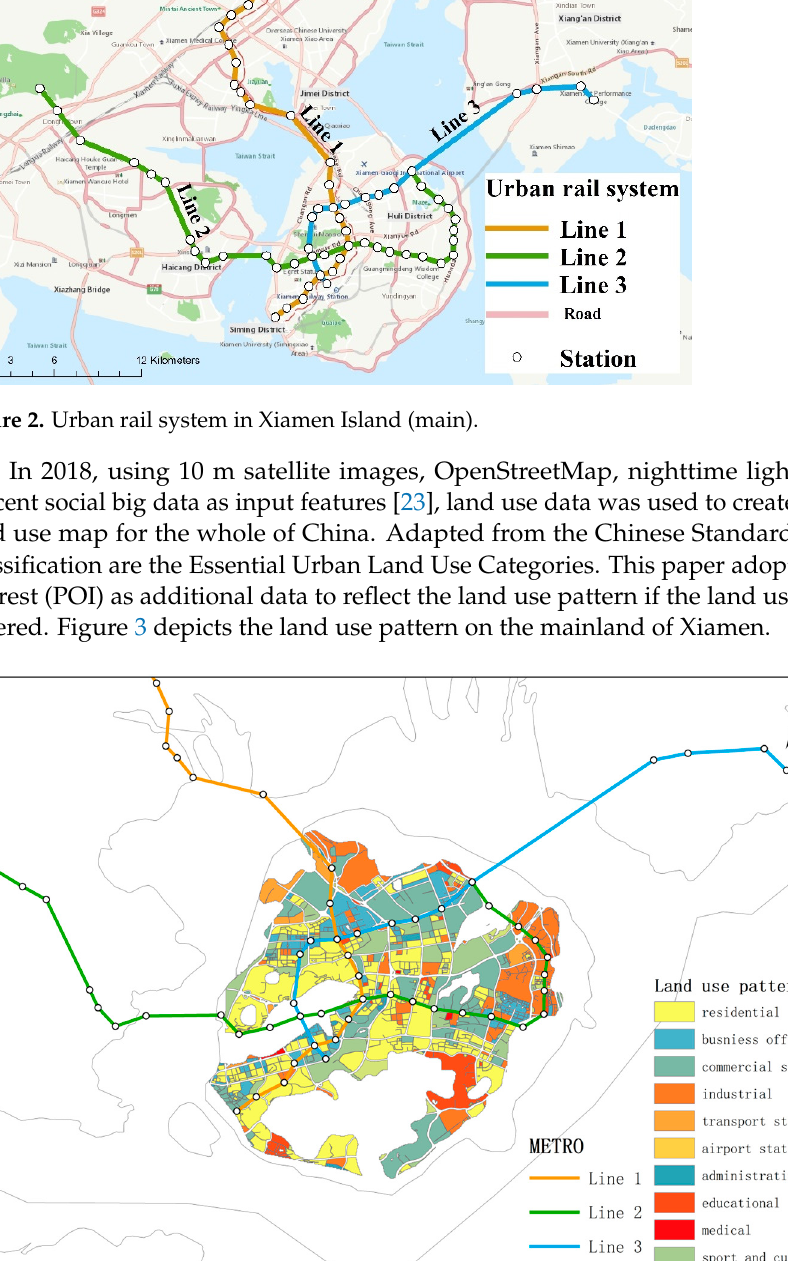
Figure 1. Location of Xiamen Island (main).